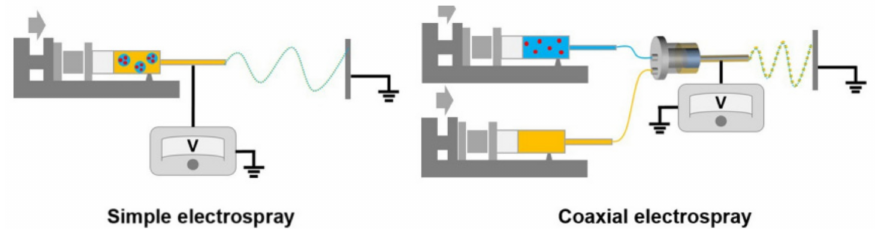
Figure 9. Schematic representation of experimental setup for simple electrospray ( left ) and coaxial electrospray ( right )